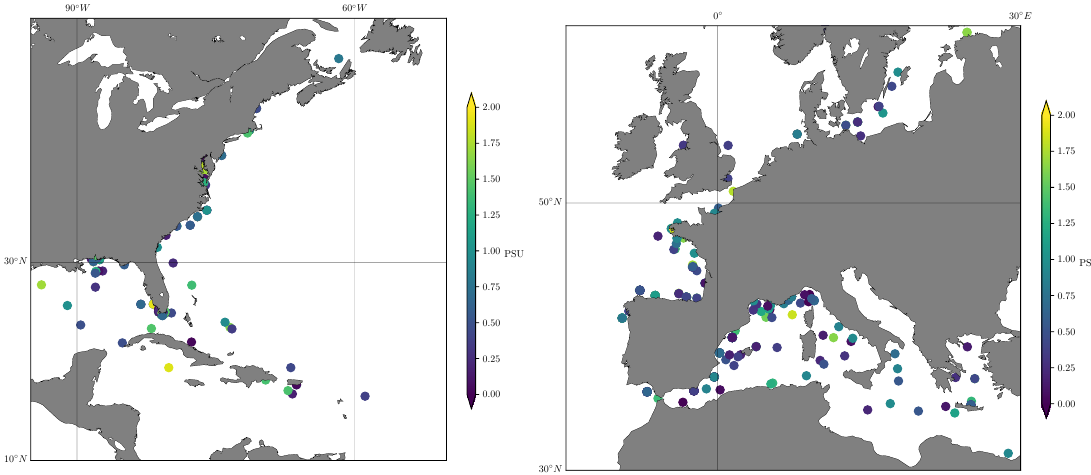
Figure 7. Detail extracted from Figure 6 showing the difference between measured and predicted salinity in test locations for the United States ( left ) and Europe ( right